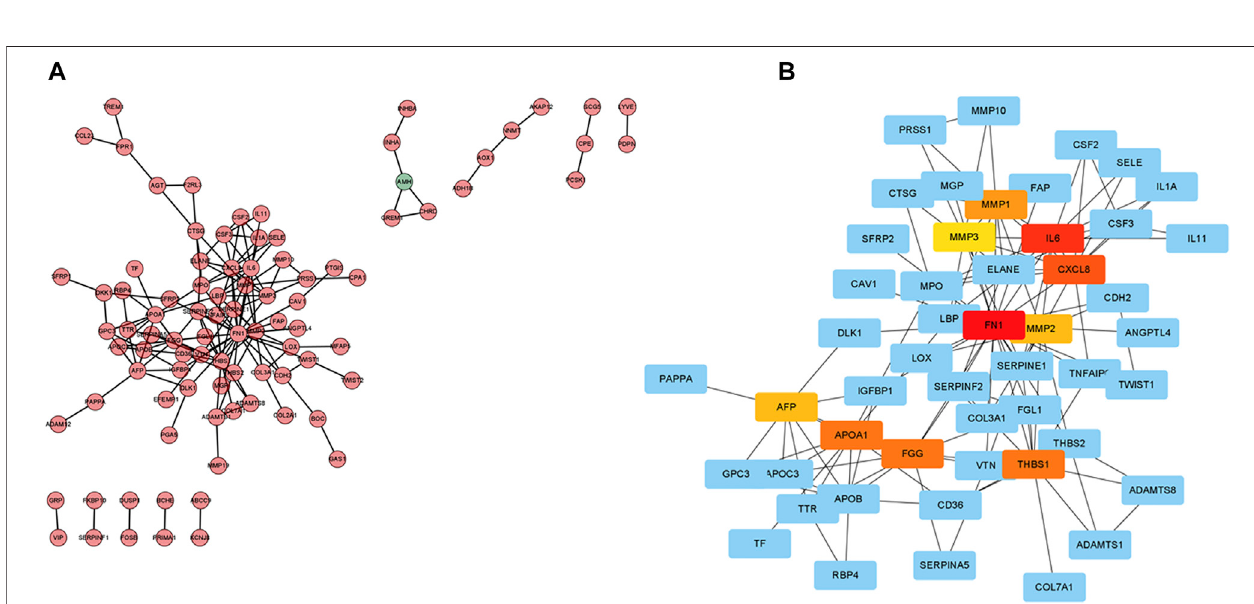
FIGURE 8 | Protein – protein interaction (PPI) network. (A) Cytoscape-treated PPI network. Red, highly expressed DEGs in the high-risk score group; green, highly expressed DEGs in the low-risk score group. (B) CytoHubba identi fi ed the top 10 hub genes.